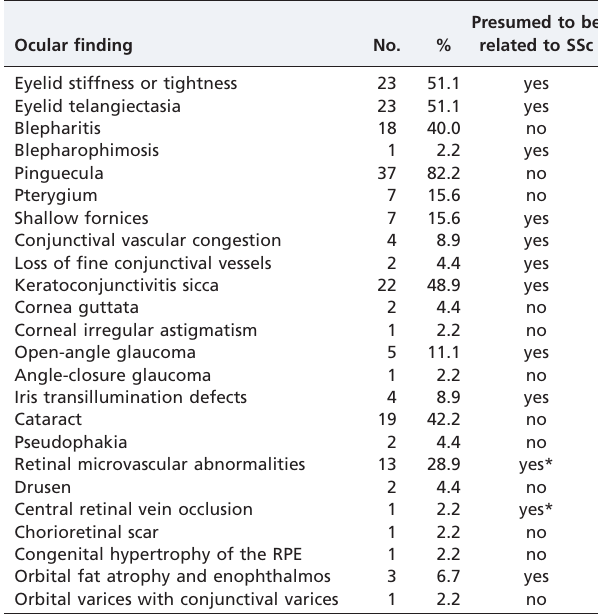
Table 2 - Prevalence of ocular findings. Ocular finding Eyelid stiffness or